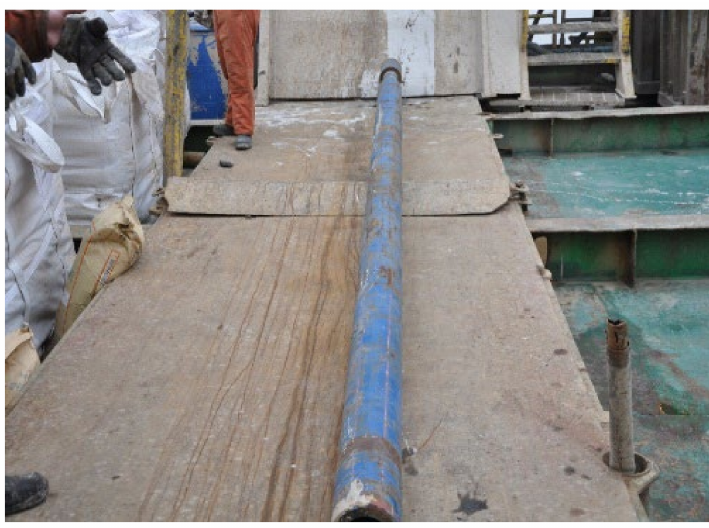
Figure 2. Physical of the drill string vibration reduction, pressurization and speed-up